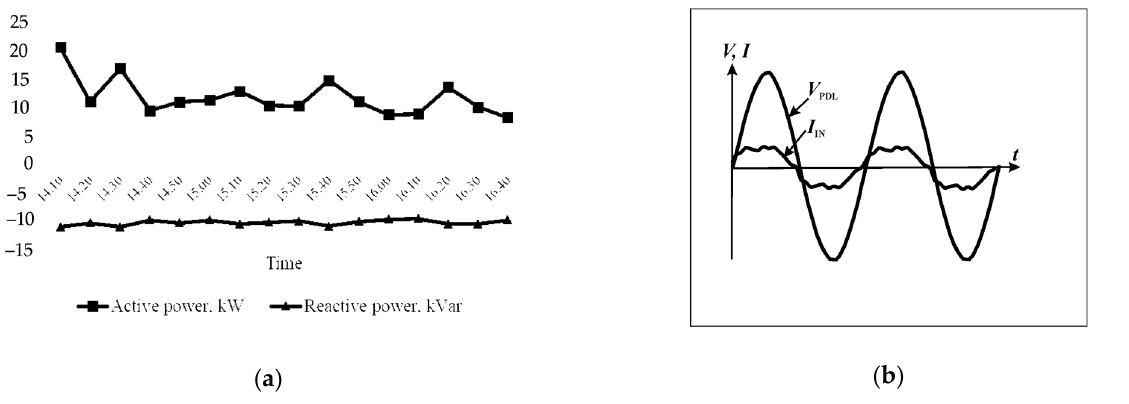
Figure 6. Data collected from the point of connection between the LED wall display and the 0.4 kV power distribution lines: ( a ) Active and reactive power measurements; ( b ) Time diagrams of the LED supplier’s input voltage and current.